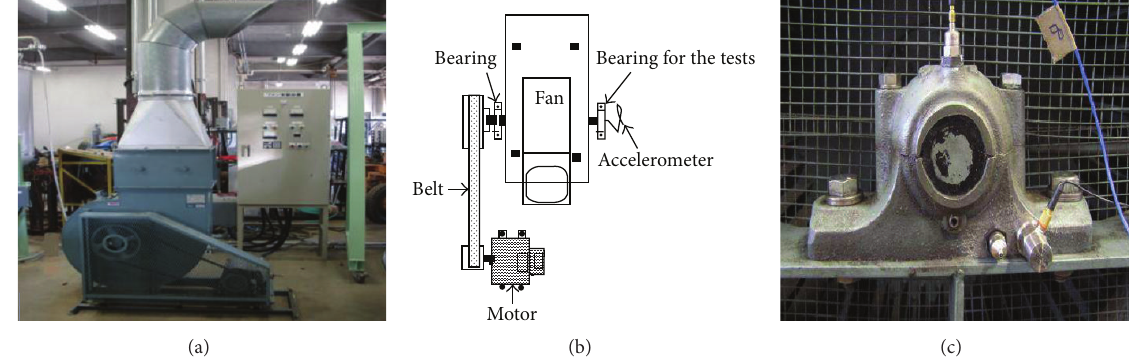
Figure 3: (a) Fault test rig, (b) flow diagram of the fault test rig, and (c) location of the sensors.